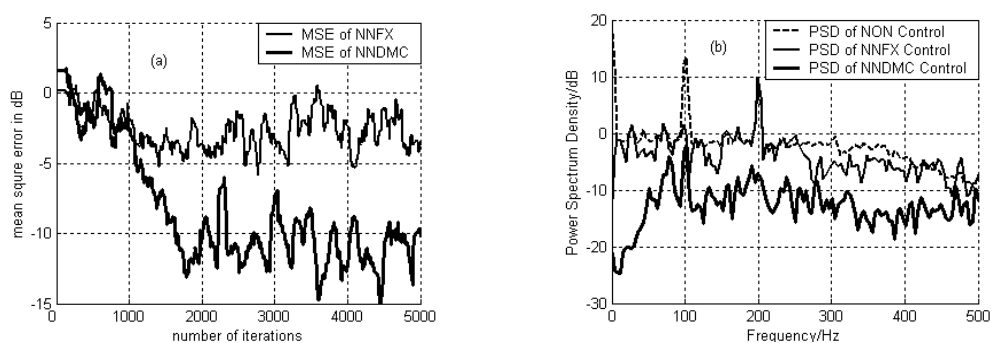
Fig. 5. (a) The error curves of proposed nonlinear DMC algorithm and NN-based nonlinear FXLMS algorithm for ANC system with off-line secondary path modeling. (b) Power spectrum of active noise canceling errors for ANC system with off-line secondary path modeling. Results from the NN-based controller are indicated in thin line, and thick line is used for the nonlinear DMC controller; the dished line indicates the results when ANC is turned